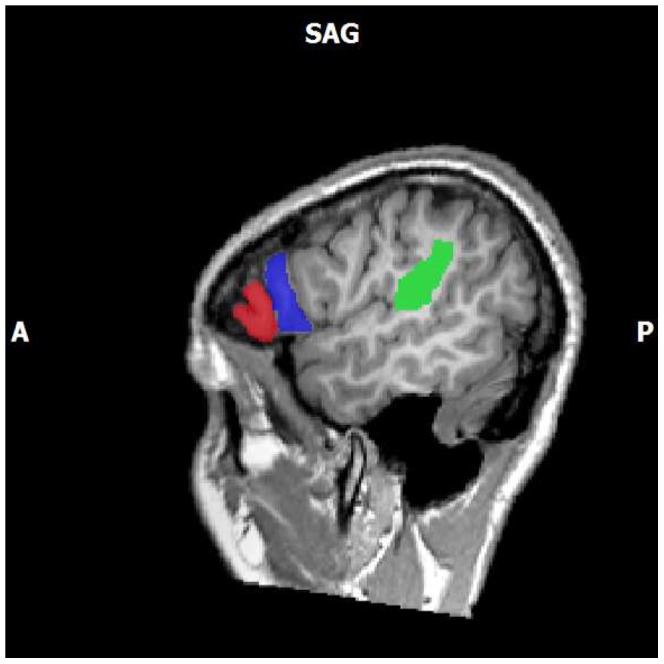
A priori defined regions of interest.ROIs were drawn on Talairach transformed MPRAGE images by hand using BrainVoyager. Limits were derived using Damasio (2005) for all regions. Pars triangularis (IFG; p.t.; shown in red), pars opercularis (IFG, p.o.; shown in blue), and inferior parietal lobule (IPL; shown in green).